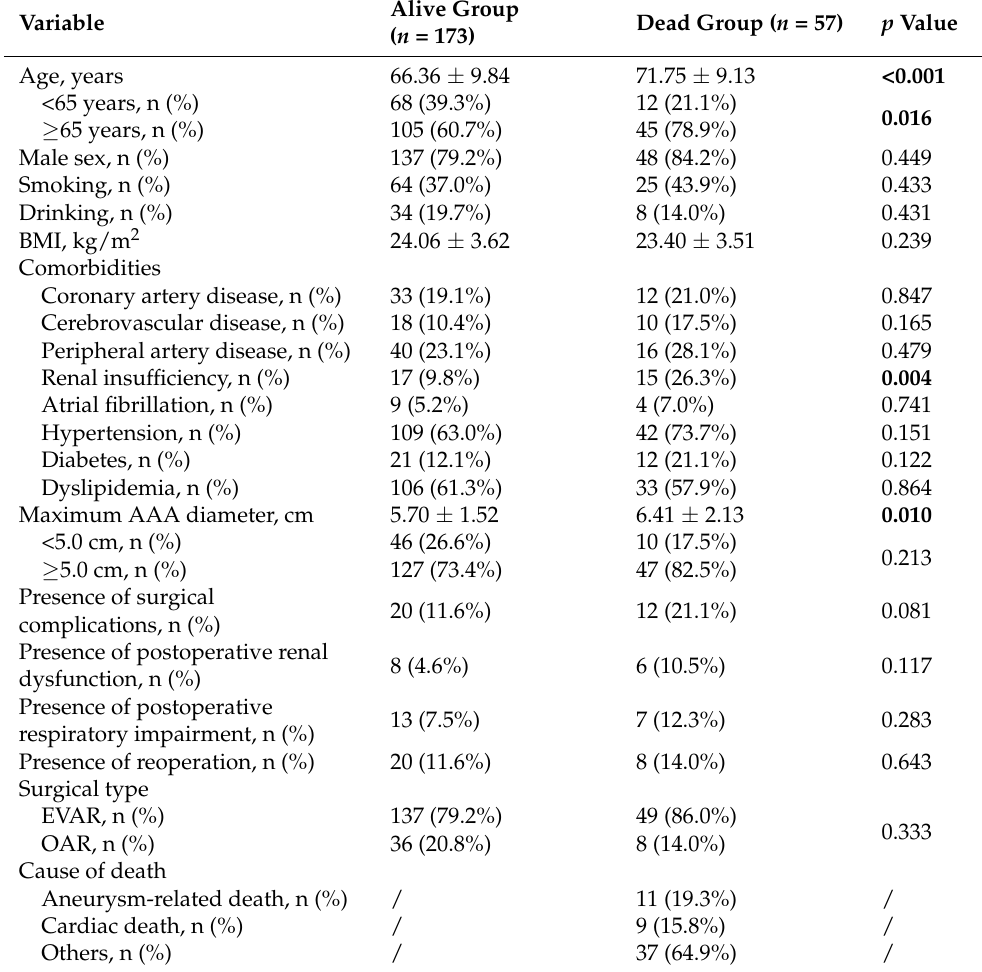
Table 1. Baseline characteristics of the total enrolled